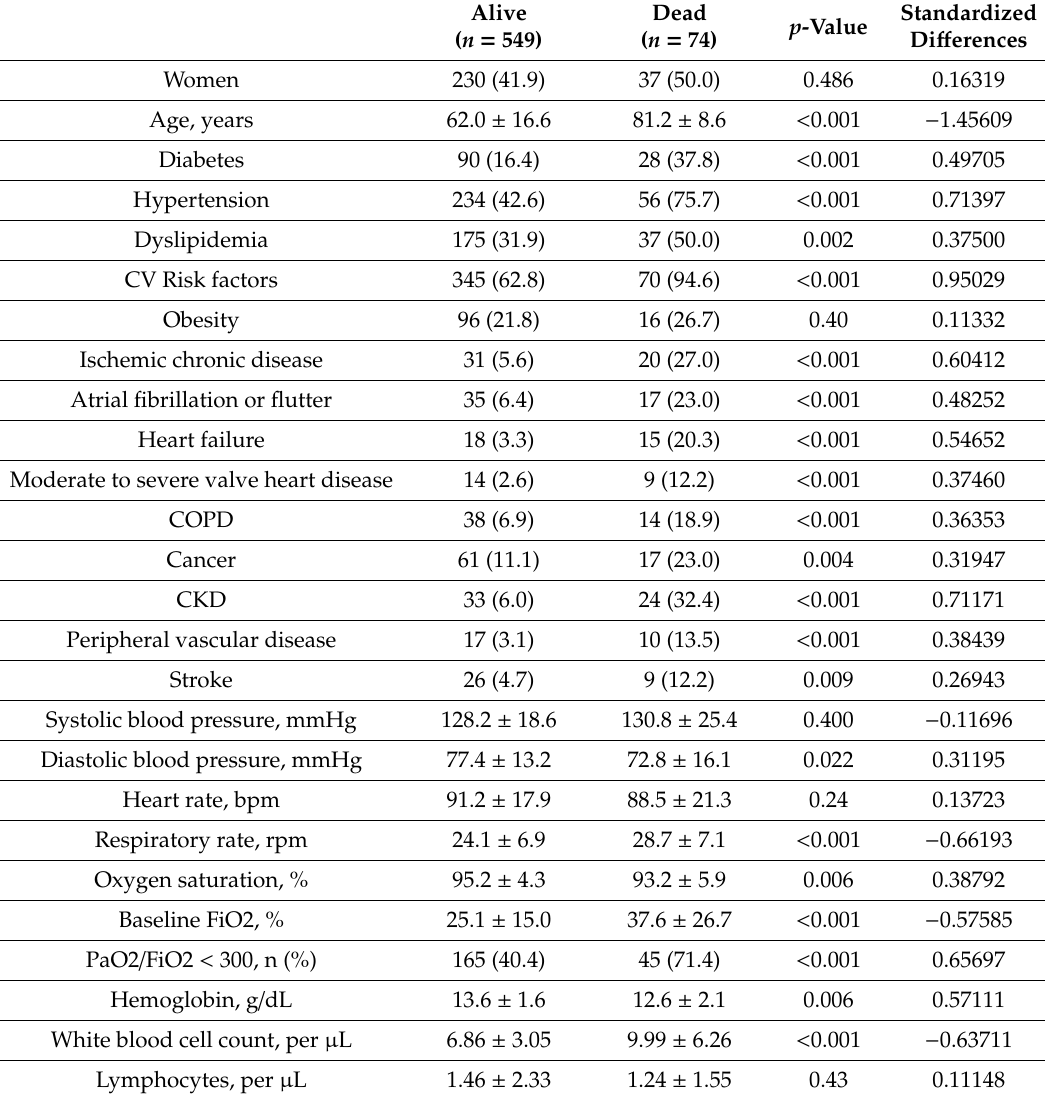
Table 2. Comparison of baseline characteristics and clinical presentation between patients alive and dead during